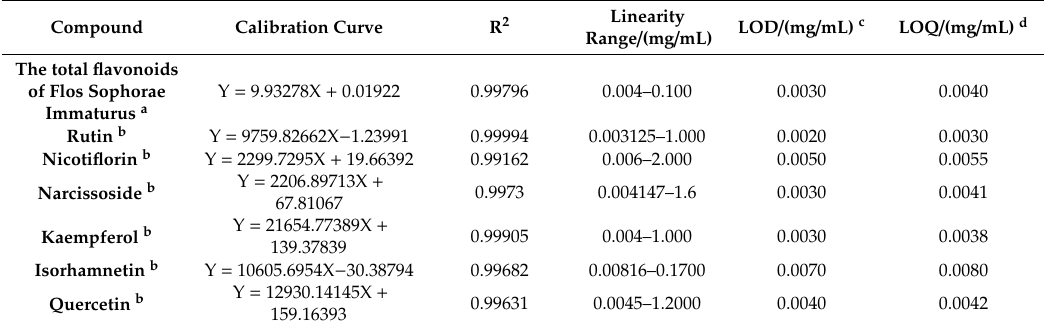
Table 3. Regression data, the limit of quantifications (LOQs, and the limit of detections (LODs) for TFFSI and six components.